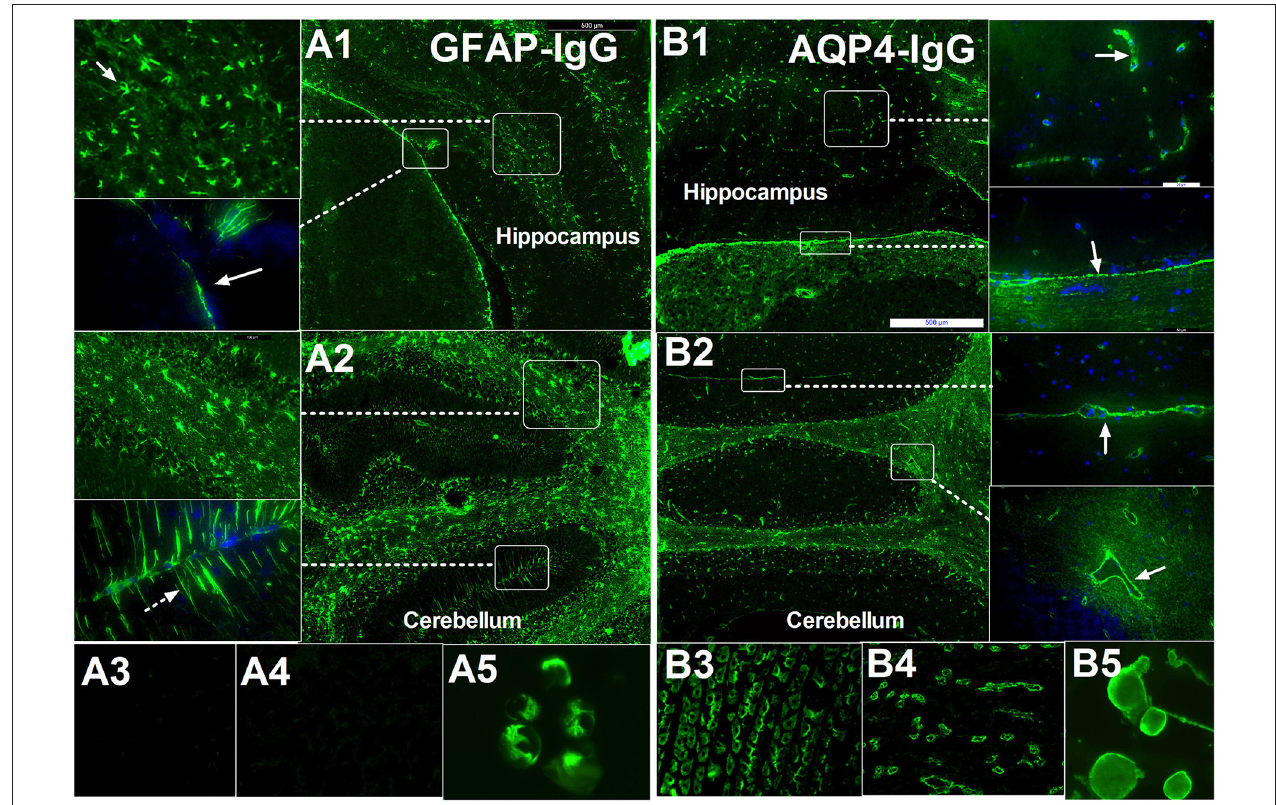
FIGURE 1 | Comparison of immunofluorescence-pattern between GFAP-IgG and AQP4-IgG. (A1–A5) IgG from patient with GFAP astrocytopathy. (A1) The IgG is bound to the foot process at pia (arrow) and astrocyte body in hippocampus. (A2) IF pattern in different layer of cerebellum: (1) The IgG is bound to the astrocyte body in different layer, especially white matter (arrow); (2) it was detected in molecular layers with bergmann radial pattern (arrow). (A3,A4) no pattern-specific staining was detected in the kidney and stomach tissue but positive for GFAP-transinfected HEK-293 cell. (B1–B5) IgG from a positive AQP4-IgG NMO patient. (B1) The IgG is bound to the cell with the foot process around the microvessels (arrow) in brain and pia (arrow). (B2) Anti-AQP4 pattern located at the border between two molecular layers with Virchow-Robin space profile (arrow) without bergmann radial pattern. (B3–B5) Pattern-specific staining was detected in the stomach, kidney tissue, and AQP4-transinfected HEK-293